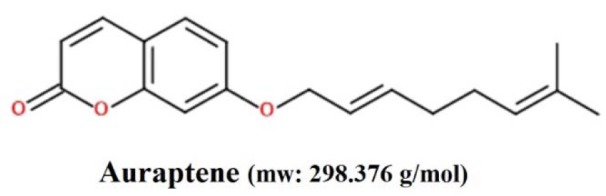
Chemical structure of auraptene